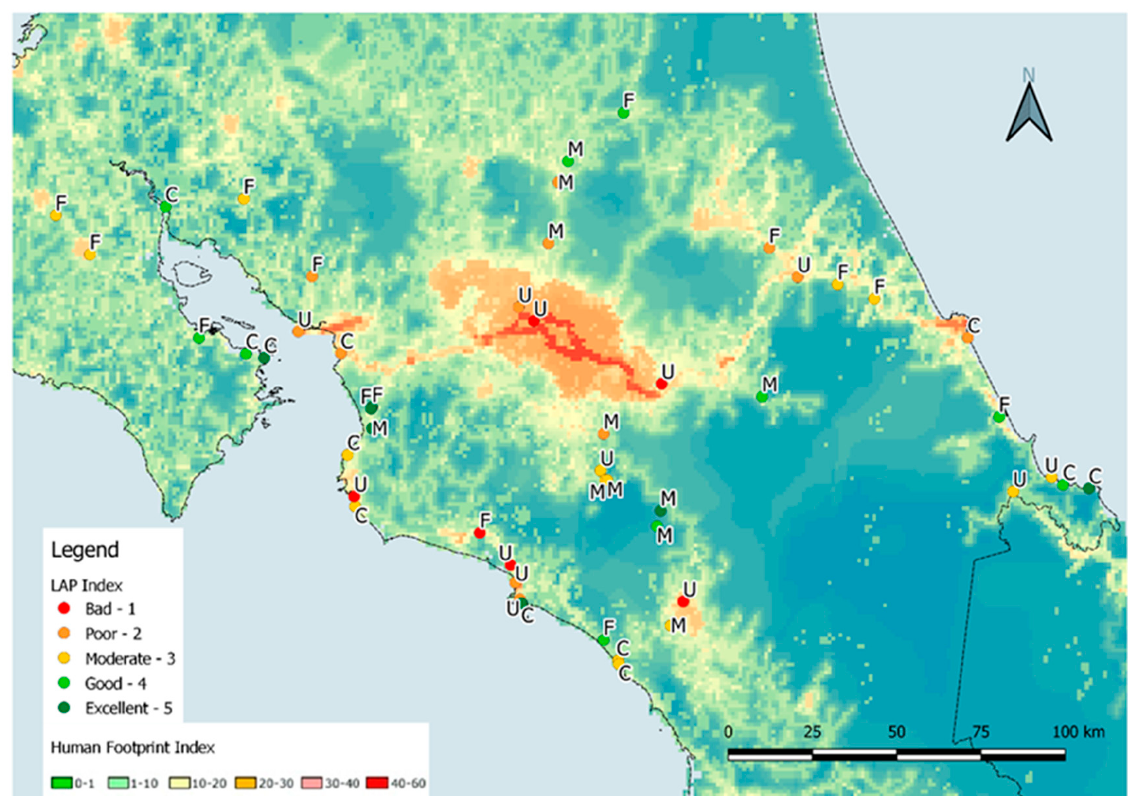
Figure 4. All surveyed sites overlain on the Human Footprint degradation assessment (warmer colors show anthropogenically degraded areas). Each point shows the LAP assessment index in five classes and the general landscape classification in four types (C = coastal, M = mountain, F = flatland, U = urban/peri-urban). The scale and map area in both maps is identical for comparative purposes.